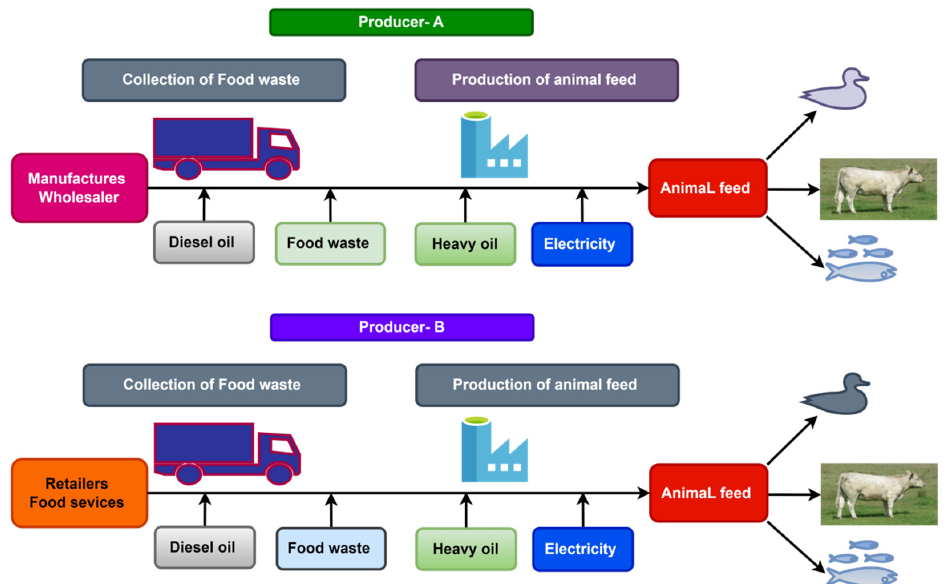
Figure 2. Utilization of FWs to animal feeding by producers ( A , B